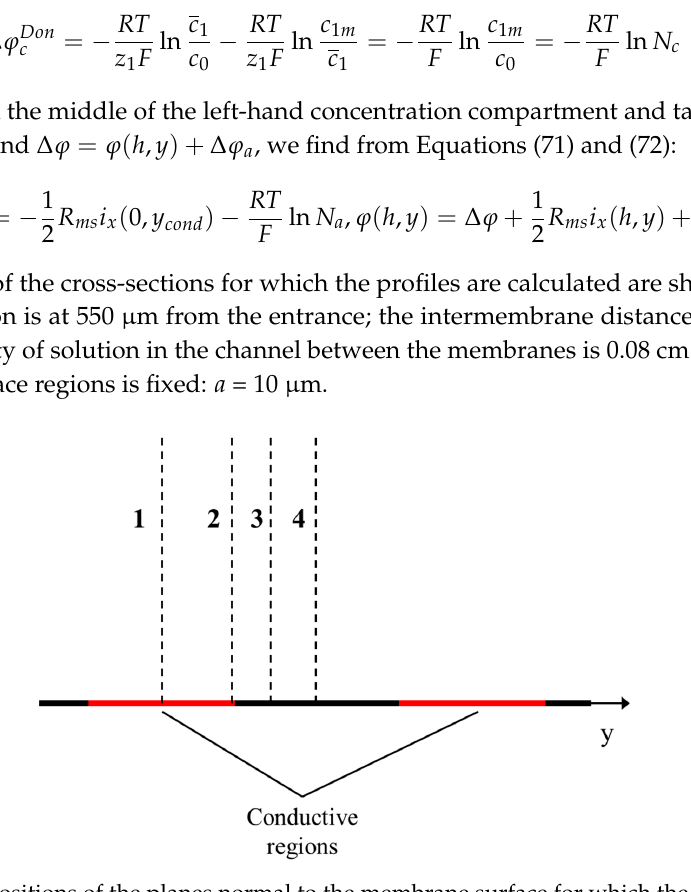
Figure 12. The positions of the planes normal to the membrane surface for which the concentration profiles are computed. Cross-section 1 is at a distance of 550 μ m from the DC entrance.